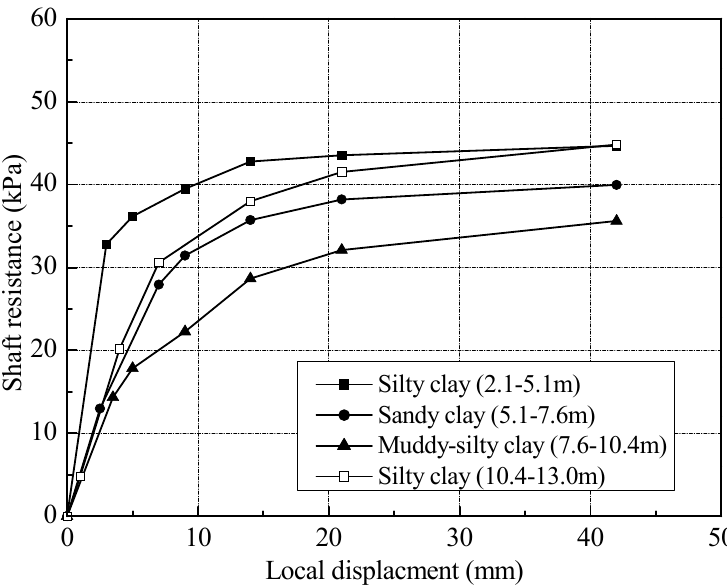
Figure 16. Distribution of unit shaft resistance of test pile.